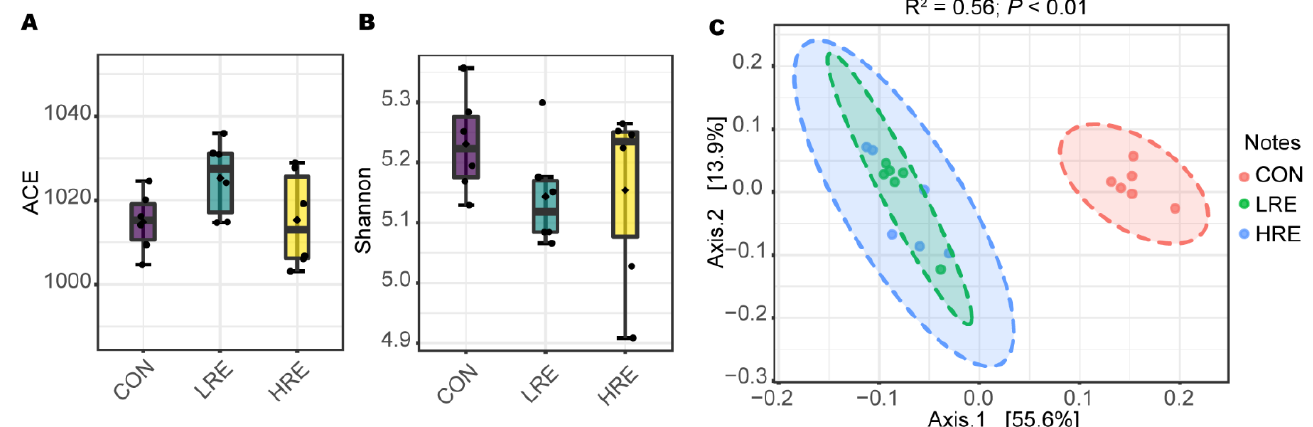
Figure 1. Effects of different doses of rosemary extract on the diversity of microbiota by in vitro fermentation technique. The α diversity indexes including the ACE ( A ) and Shannon indexes ( B ) were calculated based on the OTU level. Principal coordinate analysis (PCoA) combined with non ‐ parametric multivariate analysis of variance (PREANOVA) was calculated based on the OTU level and Bray–Curtis distances ( C ). CON, no supplementation; LRE, low ‐ dose rosemary extract supplementation; HRE, high ‐ dose rosemary extract supplementation.